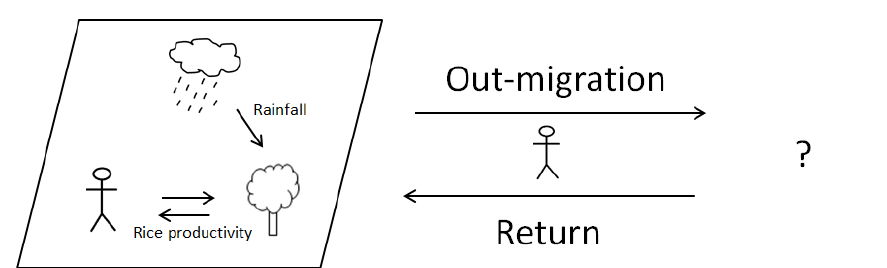
Fig. A1.8 Diagram drafted for the ABM described by Naivinit et al. (2010)